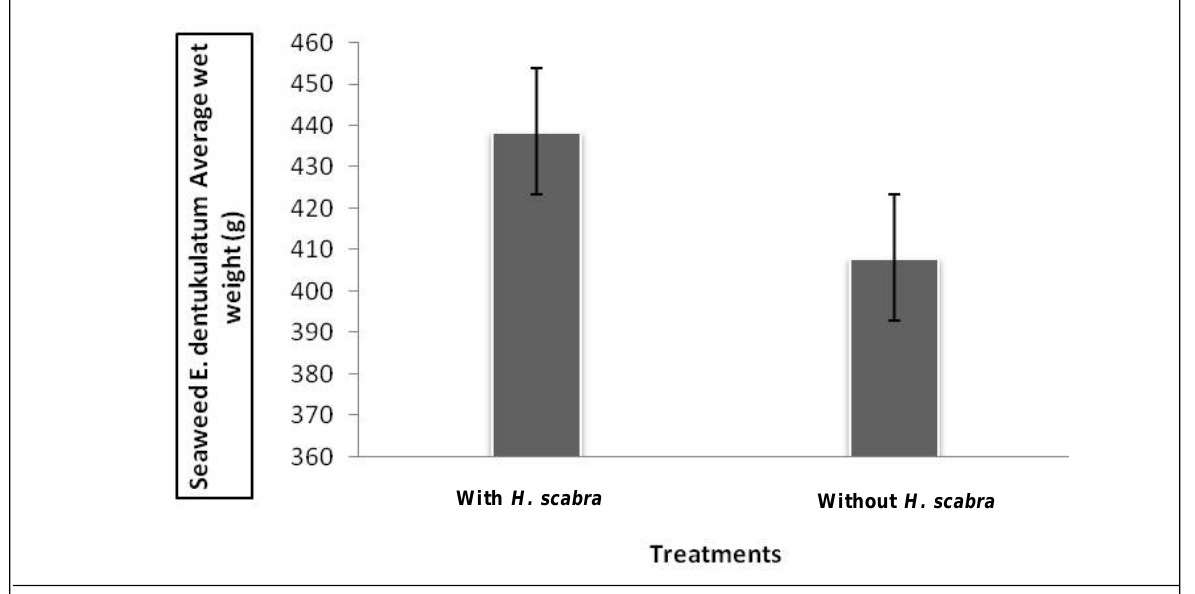
Figure 3: Mean (± SD) final wet weight of E. denticulatum co-culture with H. scabra and without H.scabra in one harvest cycle of eight weeks